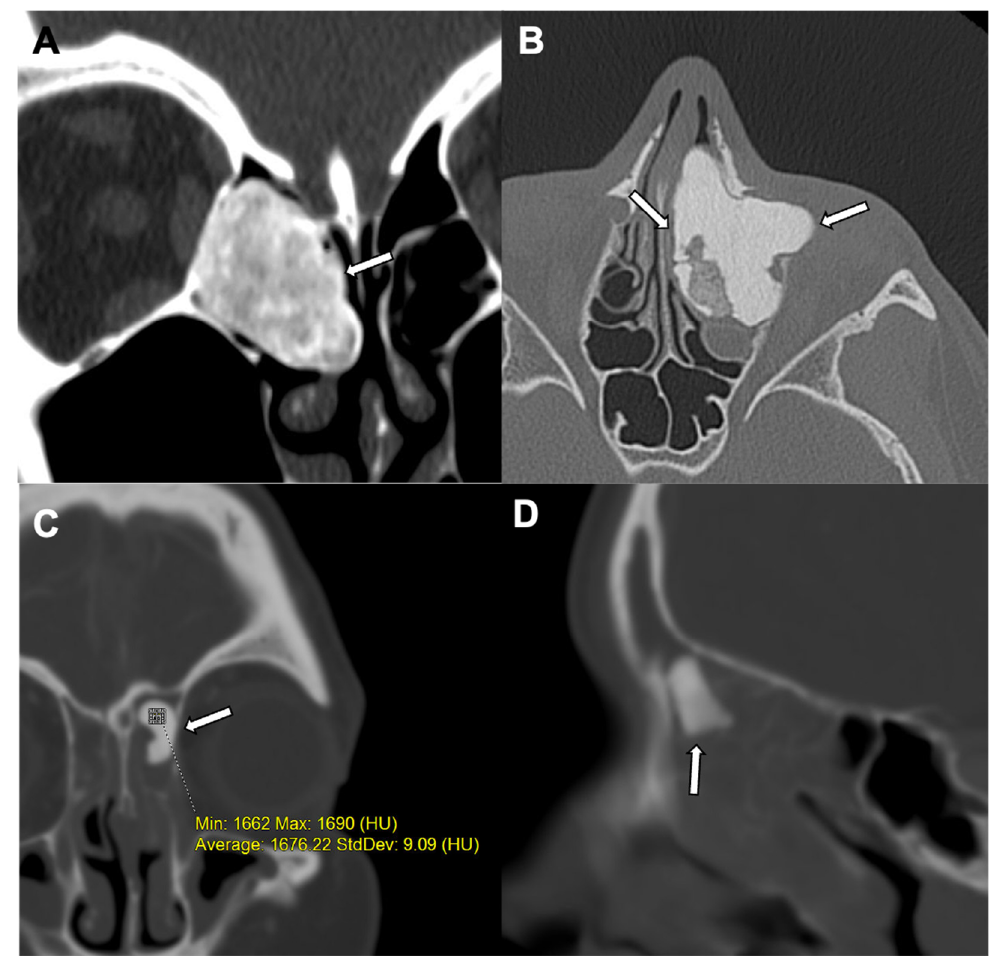
Figure 1. Osteoma: A juxtacortical circumscribed homogeneous sclerotic lesion (white arrow) in the right anterior ethmoid sinus is revealed in a coronal CT of the facial bone window, suggestive of an osteoma in a 6-year-old male ( A ). A 16-year-old female with compact and trabecular sclerotic polypoidal osteoma (white arrow) is seen in the left anterior ethmoid sinus with associated mild ethmoidal sinusitis in axial CT of the sinus bone window ( B ). An osteoma causing mild mass effect on the adjacent left inferomedial orbital wall. Another well-defined sclerotic lesion in the left frontoethmoidal recess (white arrows) is seen on coronal and sagittal CTs of the sinus bone window ( C , D ) with moderate pan sinusitis in a 7-year-old male. Note is made of very high HU (Hounsfield Unit) values.